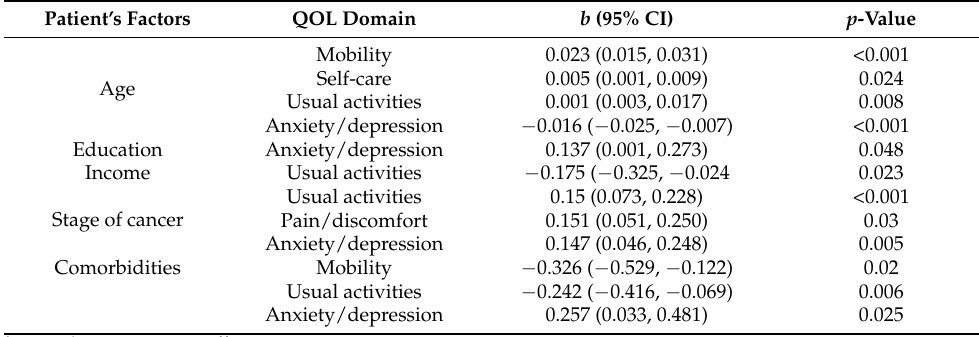
Table 8. Association of patient’s socio-demographic and clinical factors with QOL Domain based on EQ-5D-5L questionnaires.